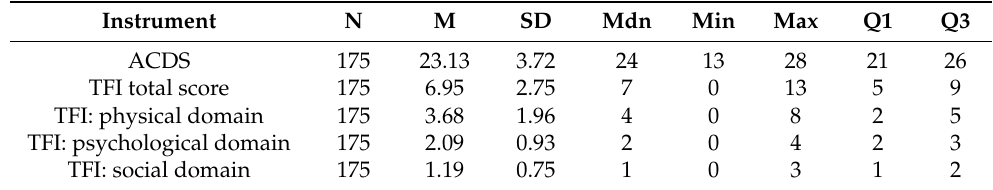
Table 3. Average distribution measures for standardized